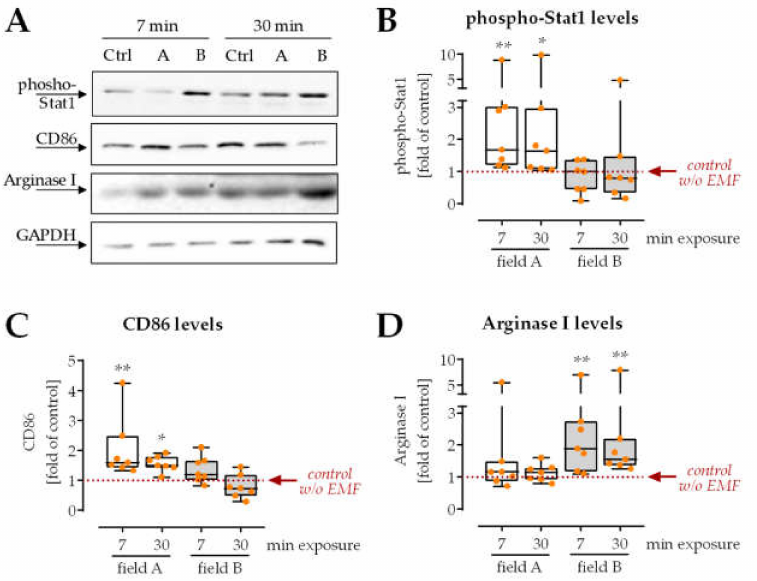
Figure 2. Macrophage differentiation is altered after single exposure to ELF-PEMFs. Freshly isolated PBMCs were exposed to the two ELF-PEMFs for 7 min or 30 min, respectively. After 24 h, markers of pro-and anti-inflammatory macrophages were detected by Western blot. ( A ) Representative Western blot images. All uncropped Western blot images are shown in Supplementary Figure S1. ( B , C ) As markers of pro-inflammatory macrophages, protein levels of phosphorylated Stat1 and CD86 were determined. ( D ) As markers of anti-inflammatory and pro-healing macrophages, protein levels of Arginase I were determined. N = 7, n = 3. Data were compared by non-parametric Kruskal–Wallis test, followed by Dunn’s multiple comparison test: * p < 0.05, and ** p < 0.01 as compared to control cells without ELF-PEMF exposure.